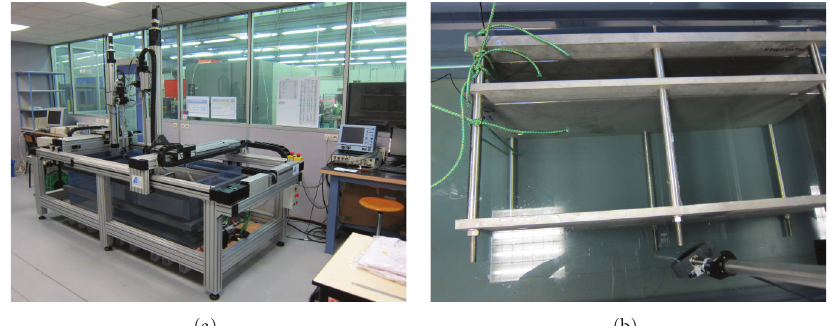
Figure 24: Scale 1 in water tests with a 3-plate (1.5m long and 1m large)